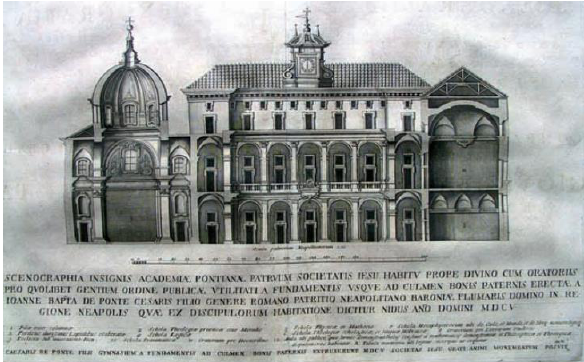
Figure 5. Section of the Collegio Massimo of the Jesuits (Pugliano